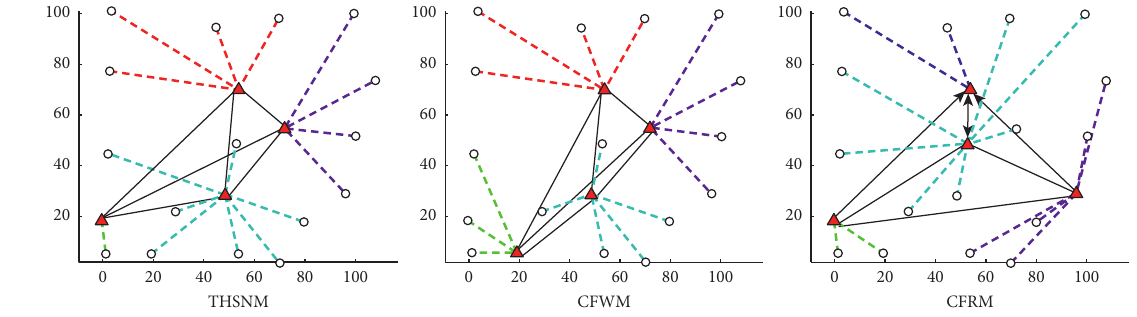
Figure 4: Comparison of model solution results. Table 4: Node allocation and flow